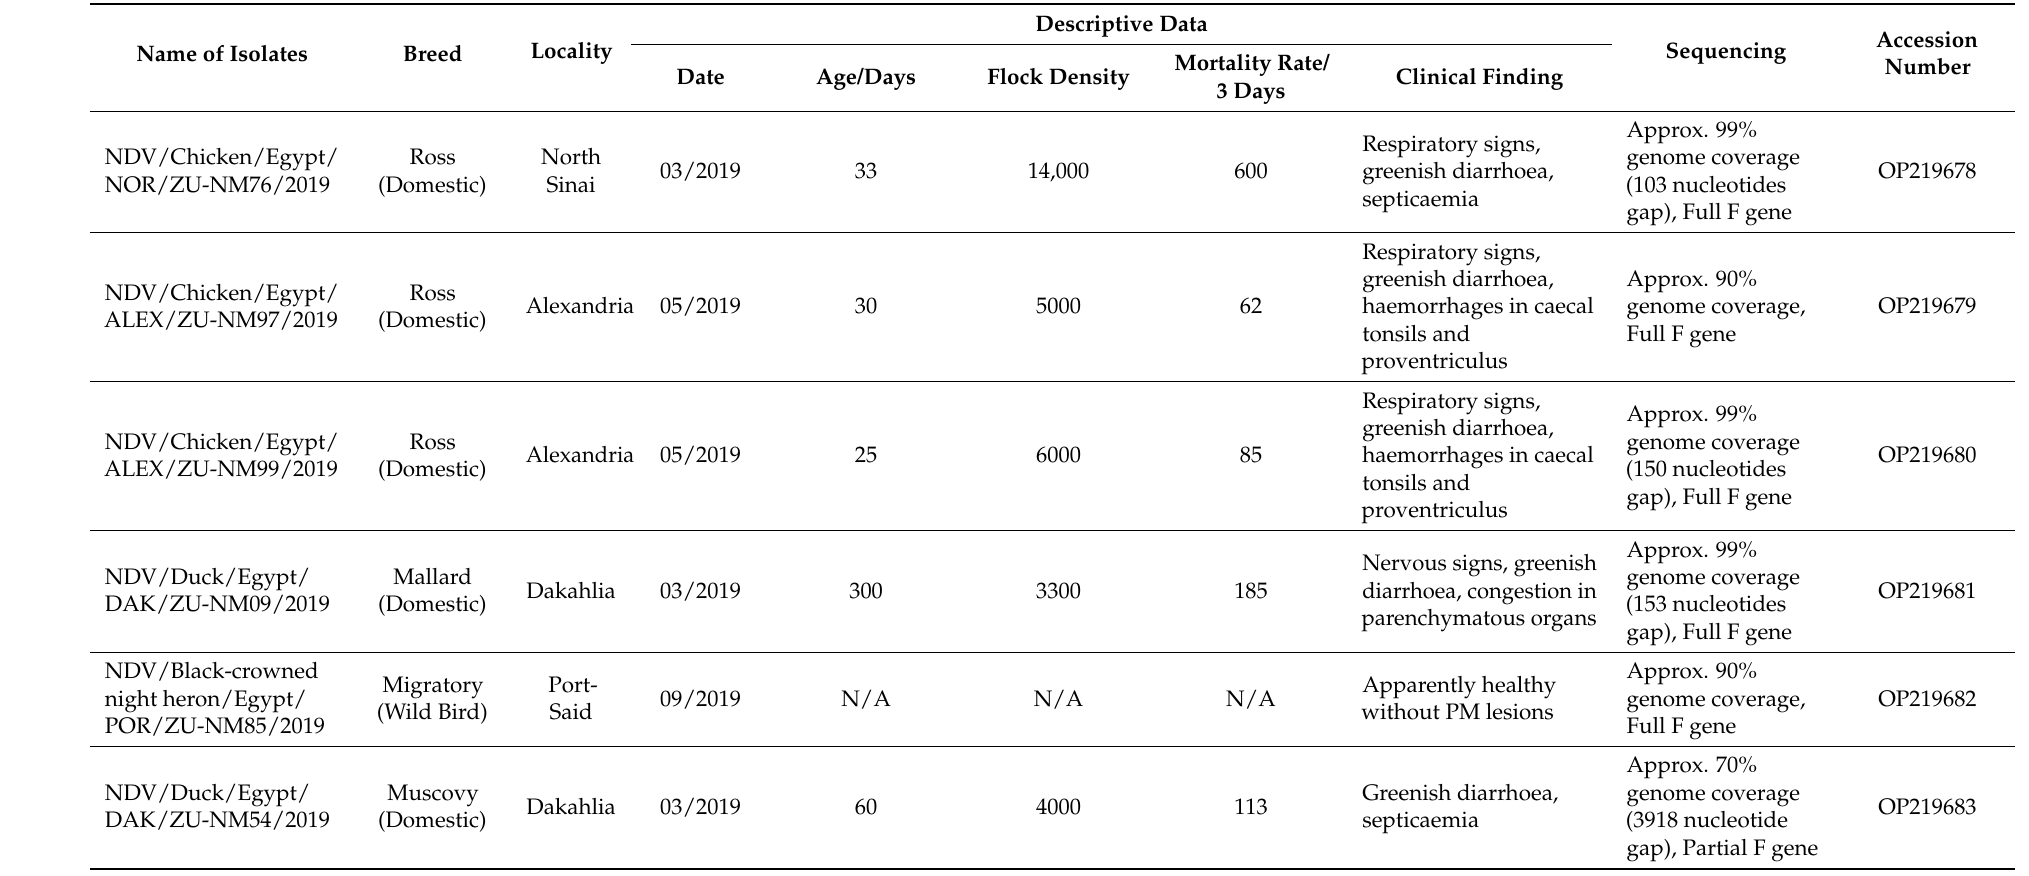
Table 5. The details of whole genome sequencing of NDV Egyptian strains of this